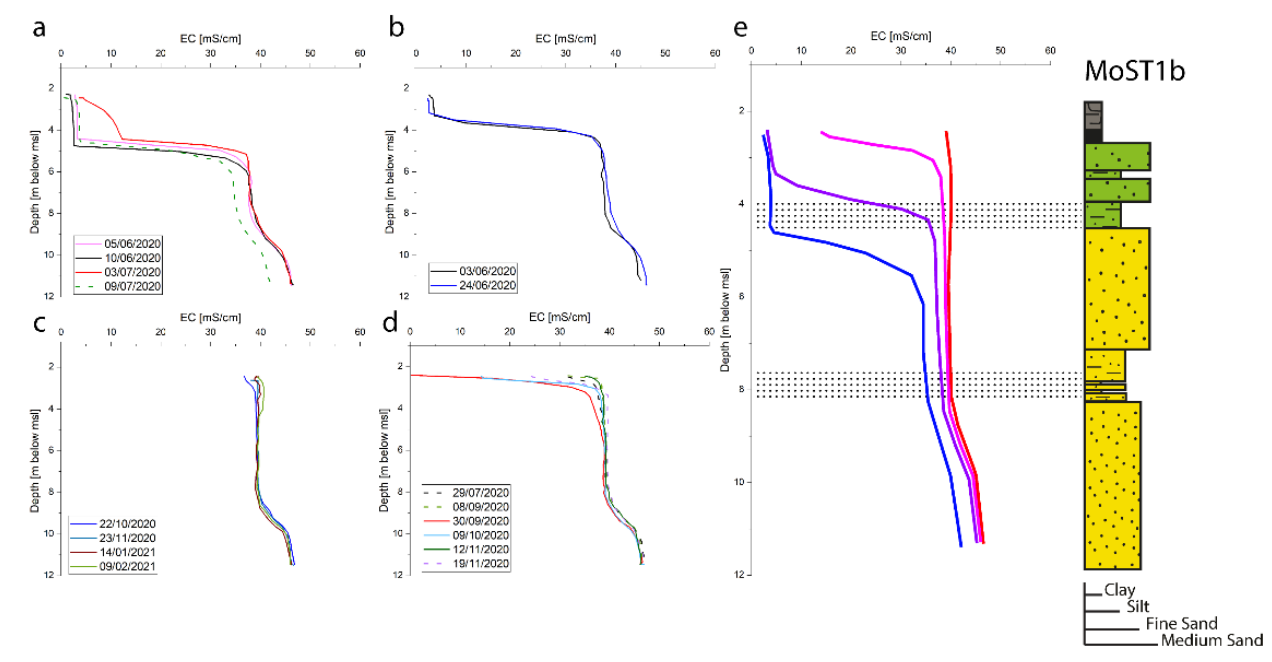
Figure 10. EC profiles collected in MoST1b well. Panels ( a – d ) show the configurations assumed by the EC curve during the observed period. The model of panel ( e ) summarizes the configurations and compares them with the stratigraphic section, outlining the sedimentary constraints (dotted areas) existing in the subsoil surrounding the monitoring point.